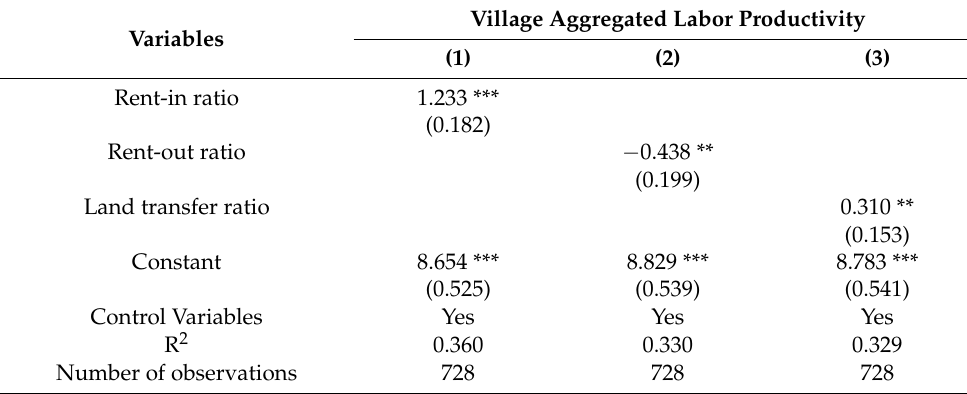
Table 6. The impact of land rental on agricultural labor productivity at village